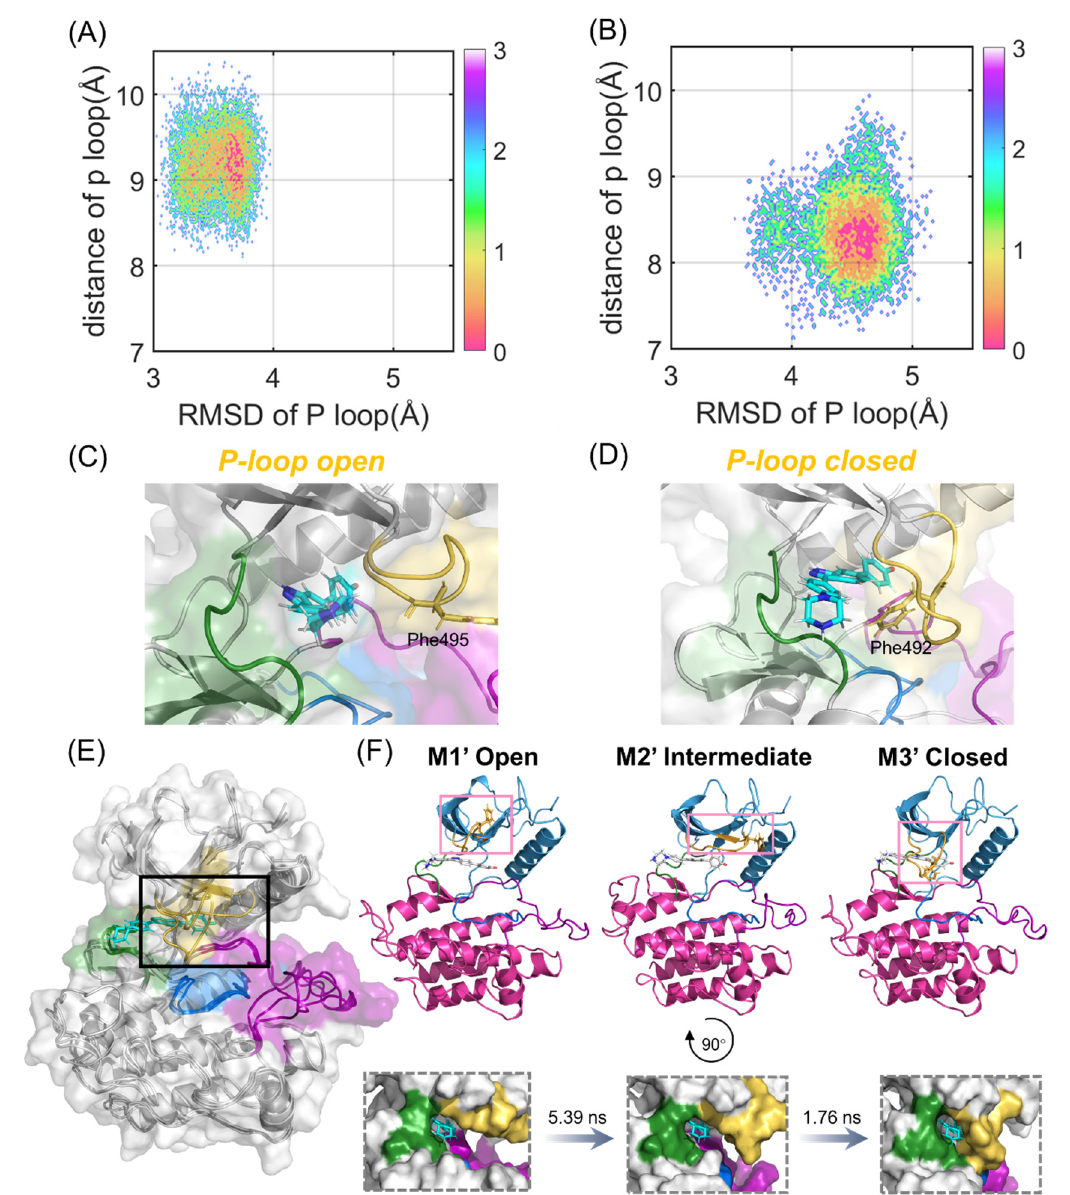
Figure 5. P-loop conformational analysis. Free-energy landscapes of FGFR1-38 ( A ) and FGFR2-38 ( B ) systems based on the RMSD and distance of the P-loop. The most representative structure in the ligand-binding domain of FGFR1-38 ( C ) and FGFR2-38 ( D ). The P-loop (orange), catalytic loop (marine), A-loop (purple), and hinge region (green) are highlighted. Phe495 in FGFR1 and Phe492 in FGFR2 are shown as sticks. ( E ) Structural overlapping of the three most represented conformations (M1 ′ -M3 ′ ) based on the PCA results in FGFR2-38. ( F ) The kinetic transition pathway of FGFR2 from the P-loop open state (M1 ′ ) to the P-loop closed state (M3 ′ ) through the intermediate state (M2 ′ ) is shown as a cartoon and on the surface, respectively. The transition timescales for the states are provided above the arrows.